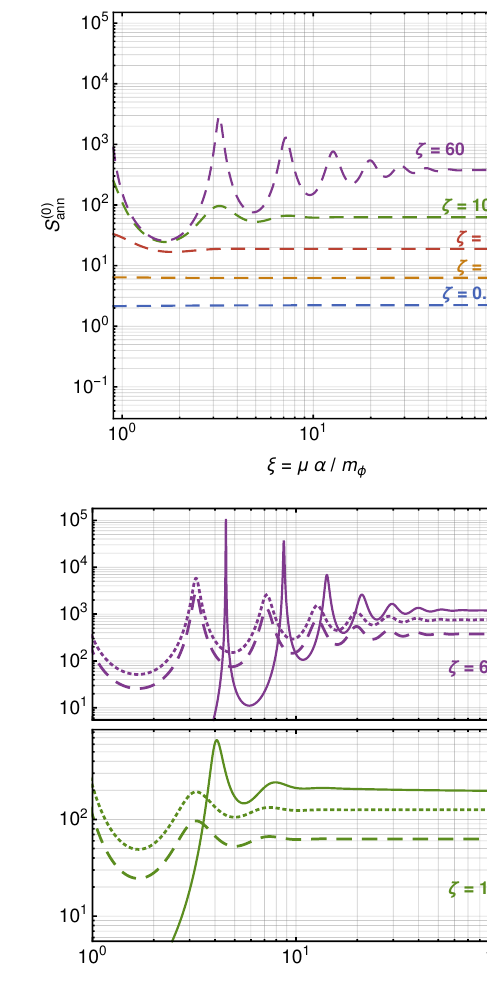
( (cid:16); (cid:24) ), appearing BSF